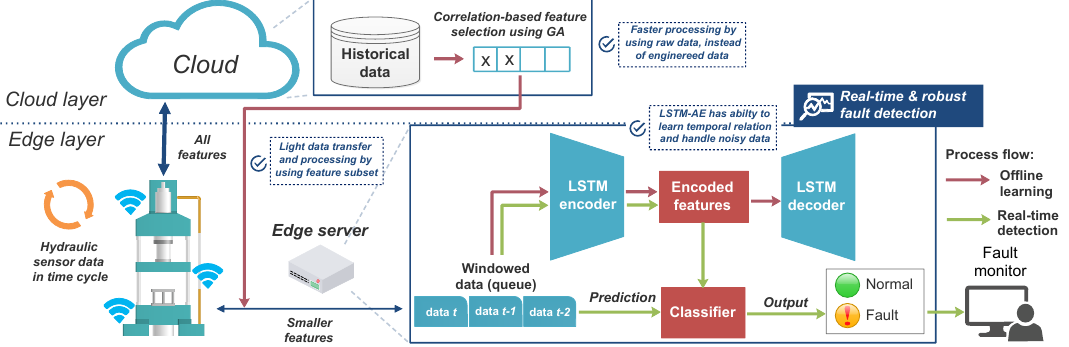
Figure 2. Architecture of the proposed real-time fault detection with edge computing. Algorithm 1 Real-time time-series fault